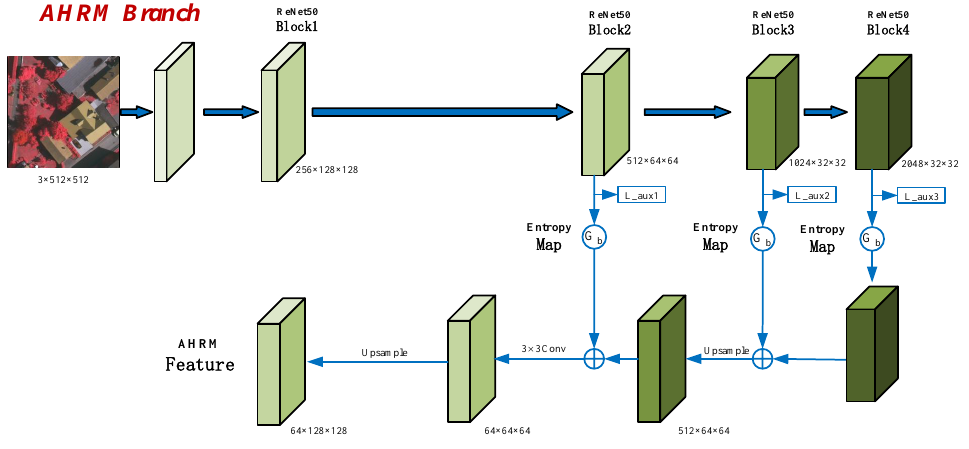
Figure 3. The framework of the AHRM